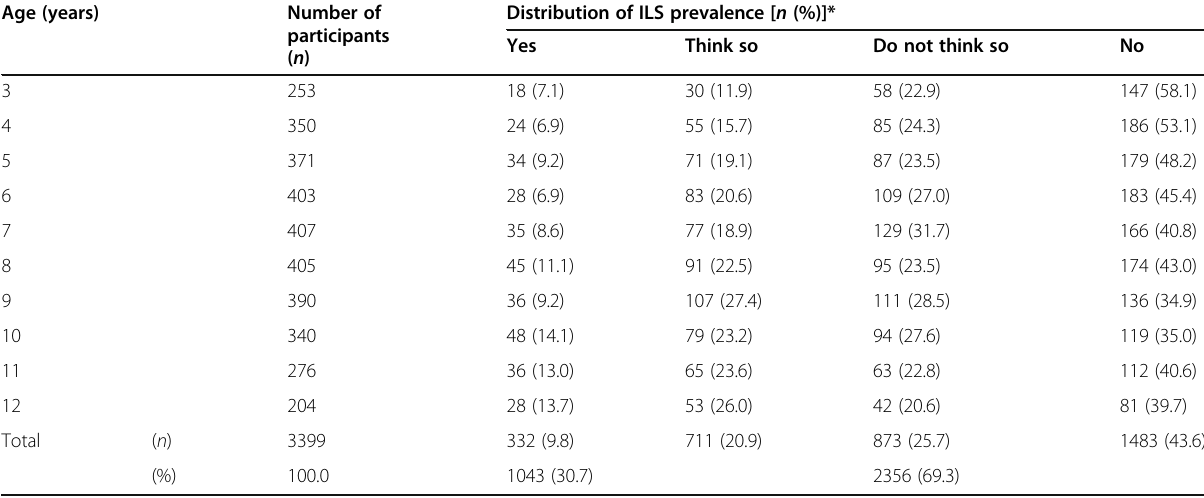
Table 3 The age-classified distribution of incompetent lip seal prevalence in Japanese children